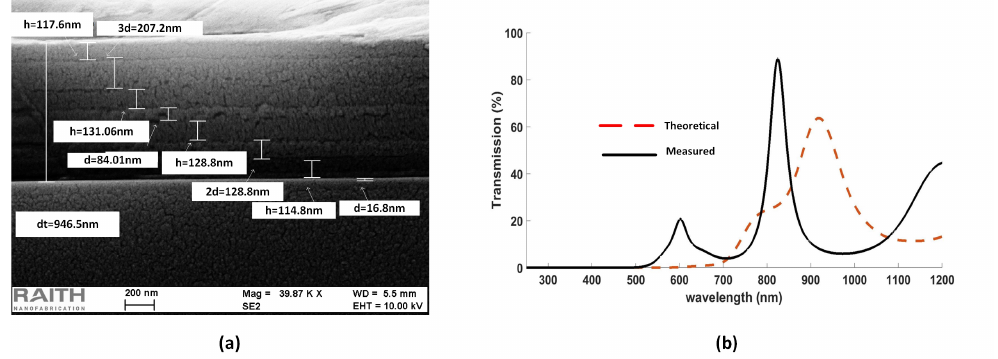
Figure 5. ( a ) SEM image; and ( b ) transmission spectrum of measured and theoretical results of multilayered thin-film cascaded